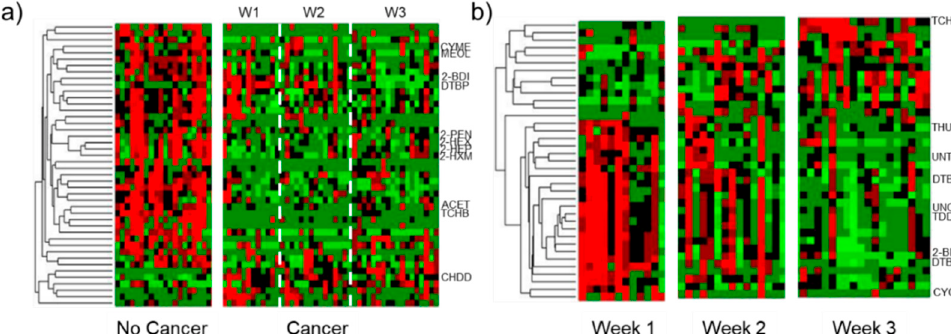
Figure 2. Hierarchical heatmaps for the VOCs identified with p -value < 0.05 in the ( a ) Cancer Weeks 1–3 vs. Control and ( b ) Cancer Week 1 vs. Cancer Week 3 comparisons. These plots show an abundant number of VOCs differentially expressed due to the presence of cancer and tumor progression. Full names of VOCs used for further analyses (but here abbreviated) are enumerated in the text and all VOCs shown in the heatmap and associated p values are listed in Table S1.